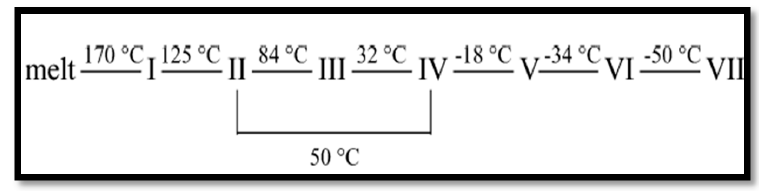
Figure 2. Phase transitions of AN.